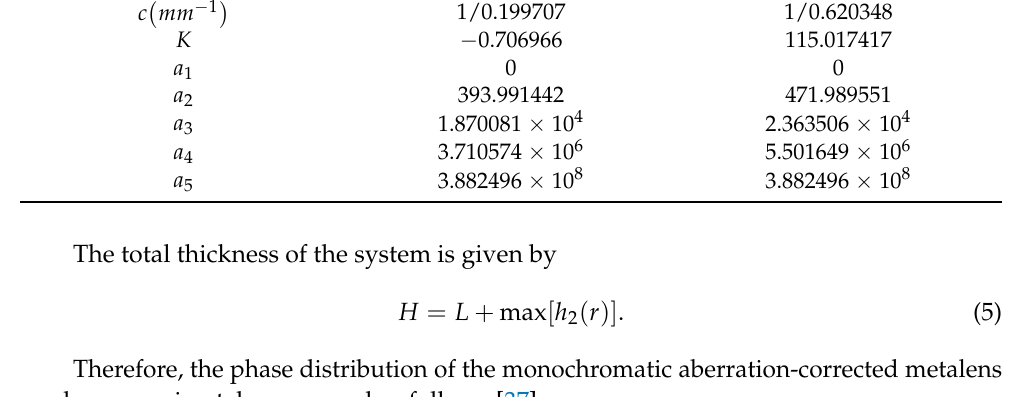
Table 1. Parameters of the aspherical lens after monochromatic aberration optimization using Zemax. 1